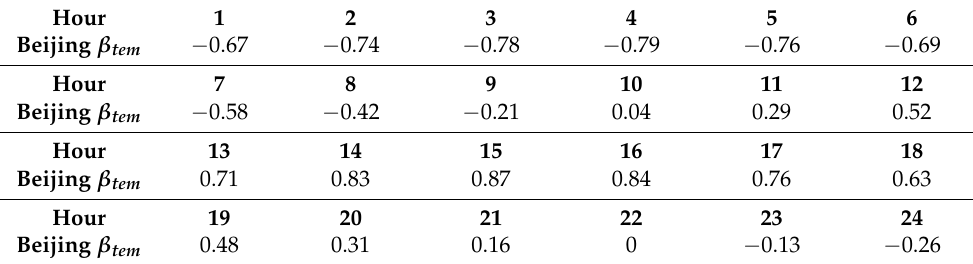
Table 5. Hourly variation coefficient of dry bulb temperature in